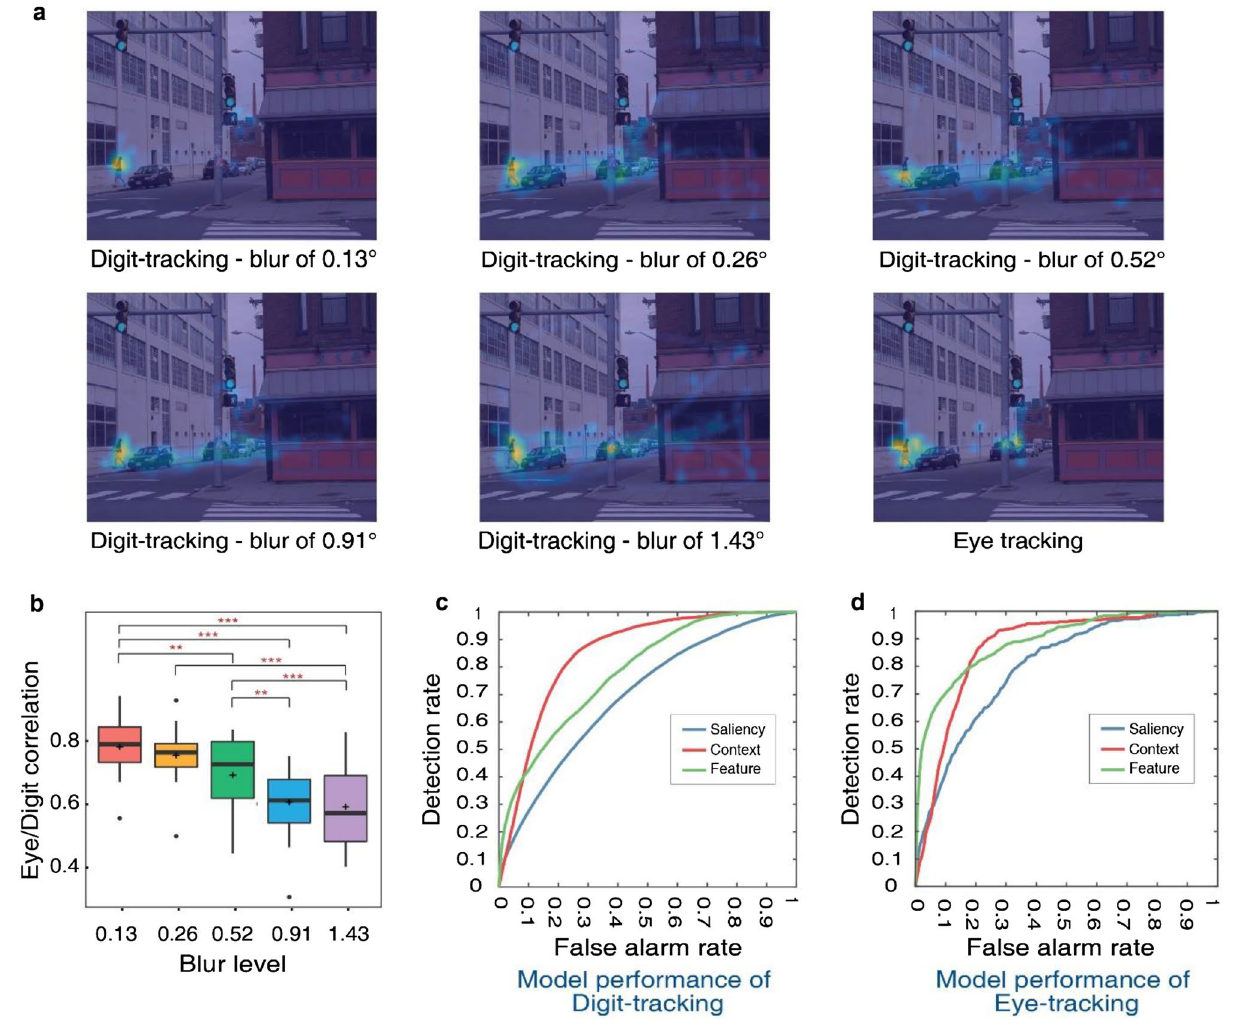
Figure 6. Results of the Experiment 3b. ( a ) Examples of digit-track attention maps at different blur levels and the eye tracking attention map computed from the Ehinger et al. 24 ( b ) The boxplot of correlation coefficients between eye-tracking maps and digit-tracking maps, **p < 0.01, ***p < 0.001. ( c , d ) show the prediction performance of different models on digit-tracking data and eye tracking